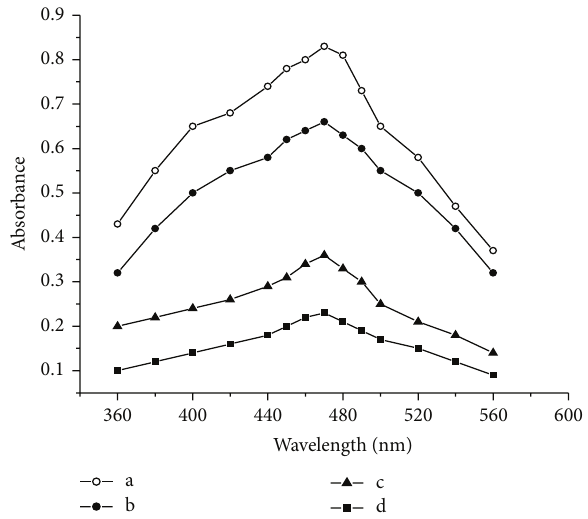
Figure 3: Absorption spectra, method C, (a, b, c, and d are absorption spectra of, blank, 2, 6, and 8 𝜇 gmL −1 KTF,